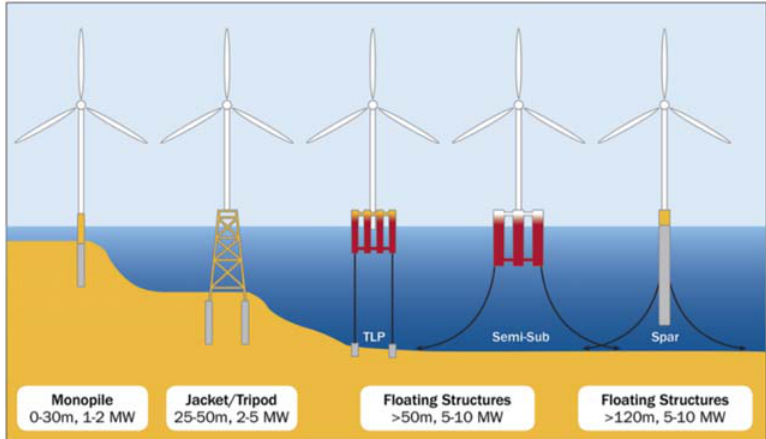
Figure 1: Types of offshore wind turbine foundations [22].